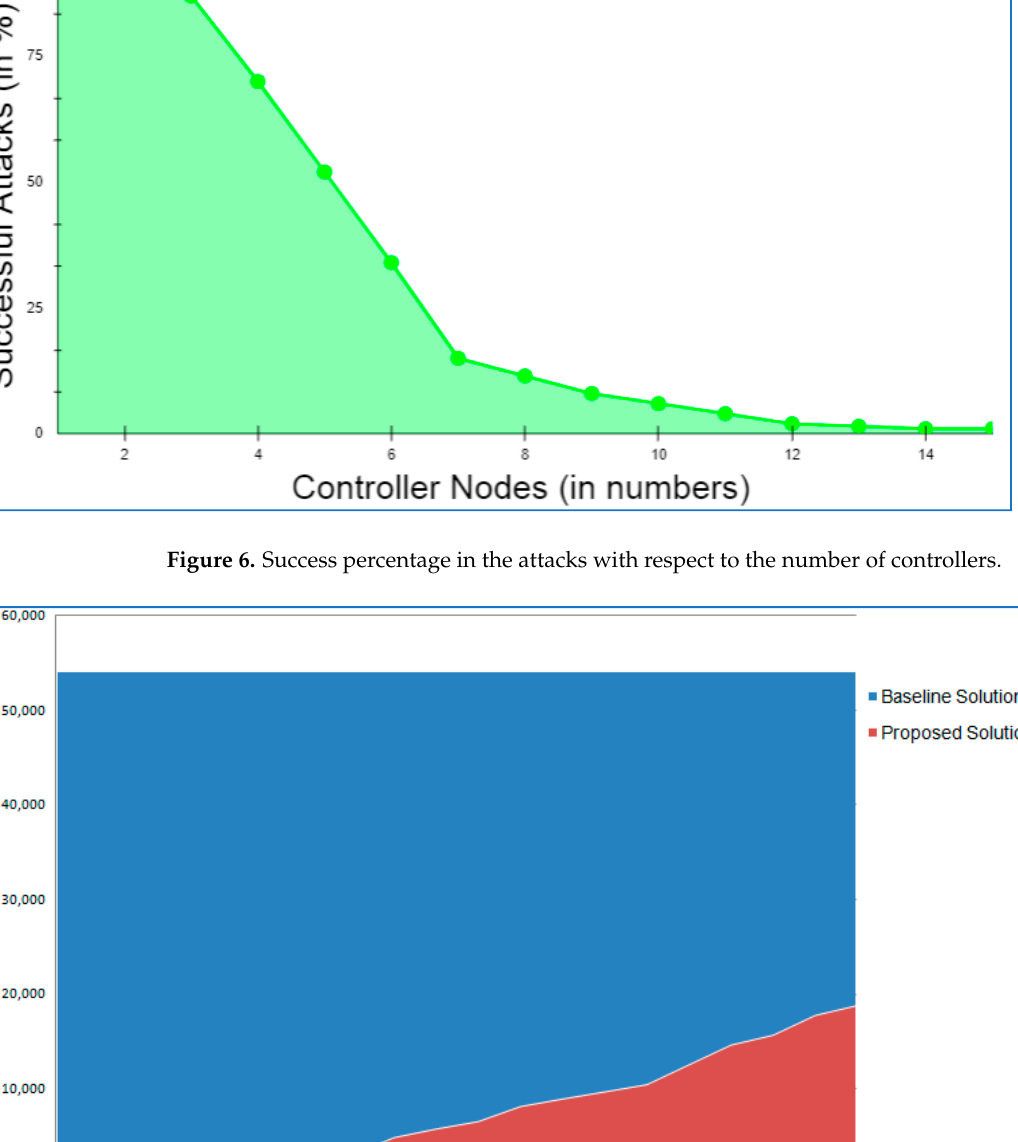
Figure 8. Energy consumption in baseline model and proposed framework at different instances.